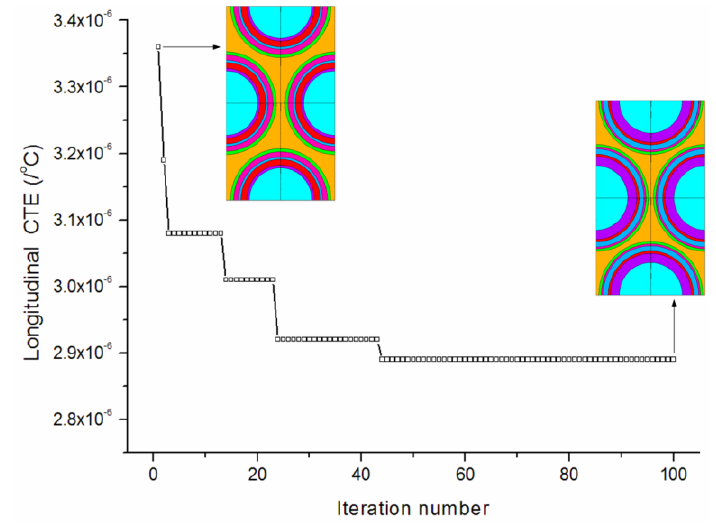
Figure 6. Convergence rates of the optimization procedure for minimizing the longitudinal CTE.